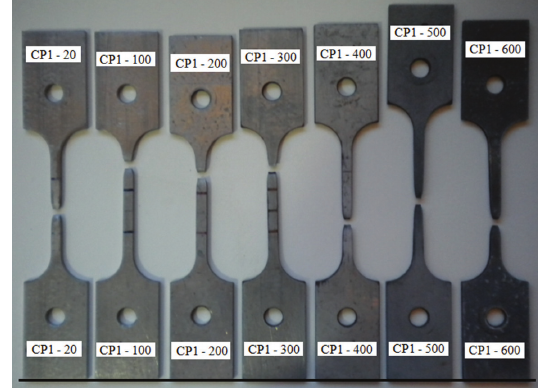
Figure 5. Typical failure modes during steady state tests.